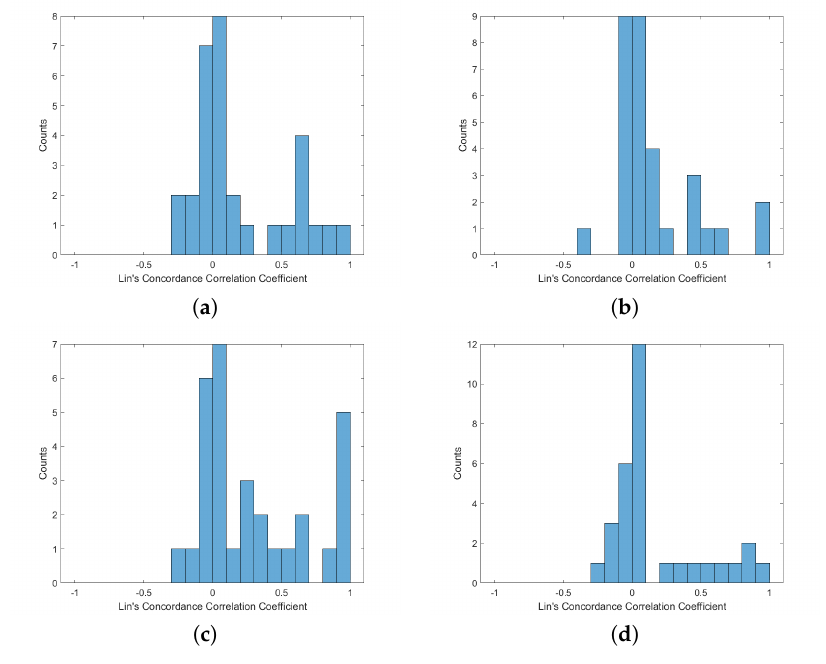
Figure A6. Histogram of Lin’s Concordance Correlation Coefficient from ECG-HRV and BCG-HRV, position “Right”: ( a ) S1; ( b ) S2; ( c ) S1 and S2; ( d ) all